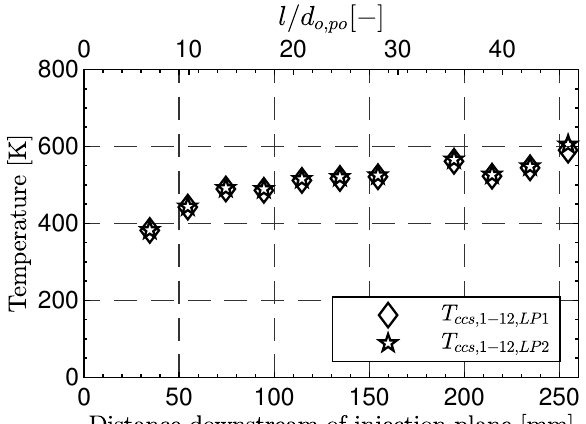
Figure 13. Temperature distribution of thermocouples in chamber wall downstream of injection